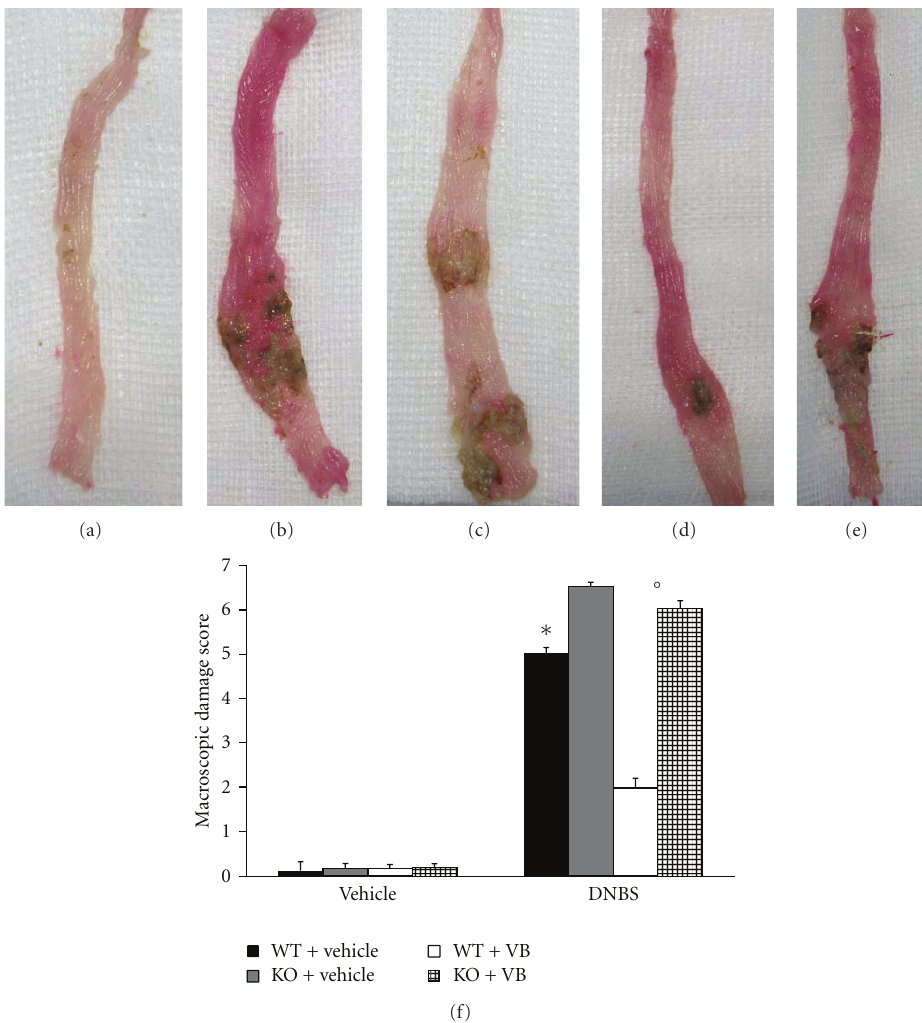
Figure 2: Role of PPAR- α in the anti-inflammatory property of VB on clinical expression of DNBS-induced colitis and macroscopic damage score. Colon tissues from sham-treated mice (a), colon tissues from DNBS-treated PPAR- α WT (b) or DNBS-treated PPAR- α KO mice (c) from mice at 4 days post DNBS administration, and the colon tissues collected from DNBS-treated mice which have received VB treatment (d). The treatment of PPAR- α WT with VB resulted in a significant decrease in the extent and severity of the macroscopic signs (d). The genetic absence of the PPAR- α receptor significantly reduced the e ff ect of the VB treatment (e). The macroscopic damage score was made by two independent observers (f). Data are means ± SEM of 10 mice for each group. ∗ P < . 01 versus Sham; ◦ P < . 05 versus DNBS-WT